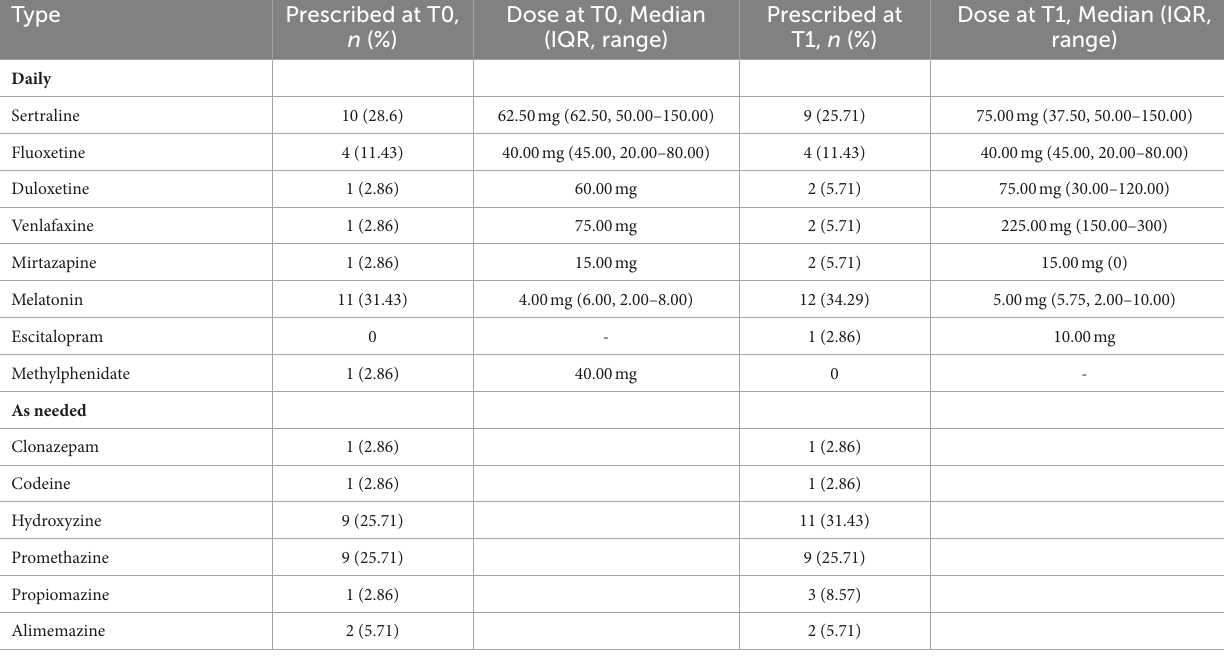
TABLE 2 Prescribed psychopharmacological medication pre- and post TARA. Type Prescribed at T0,